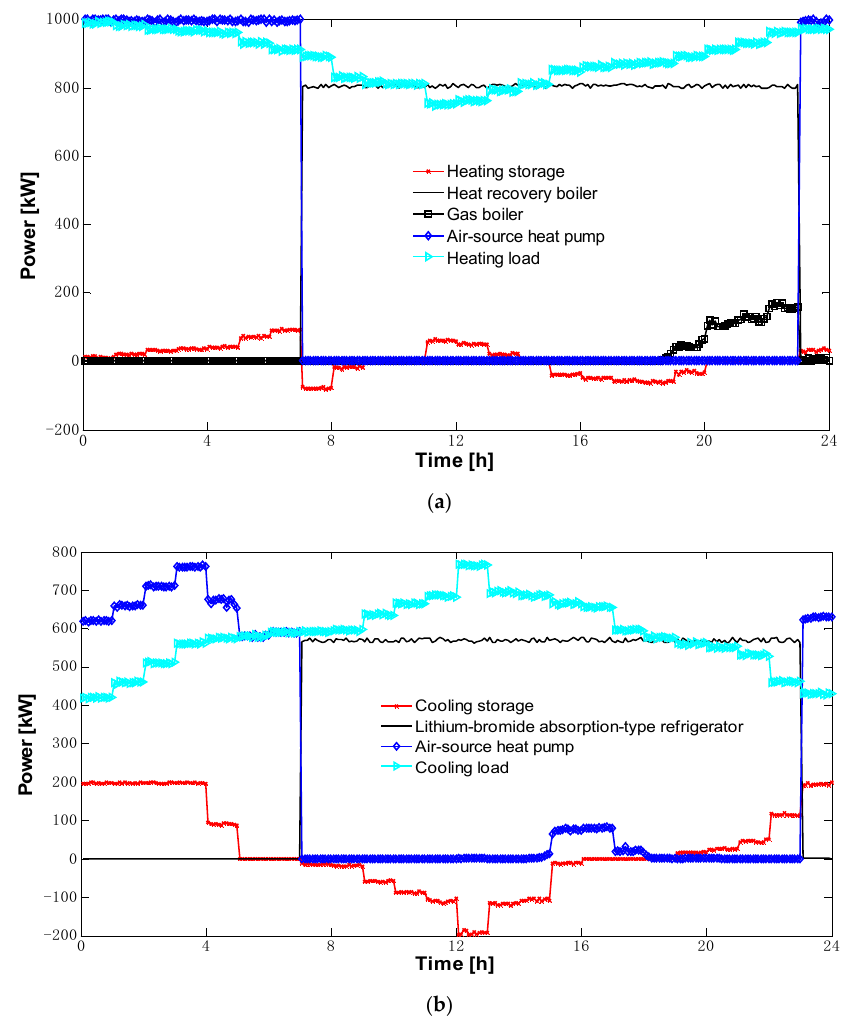
Figure 11. The heating load balance curves of a typical day in winter ( a ) and the cooling load balance curves of a typical day in summer ( b ) under real-time optimal dispatching mode.